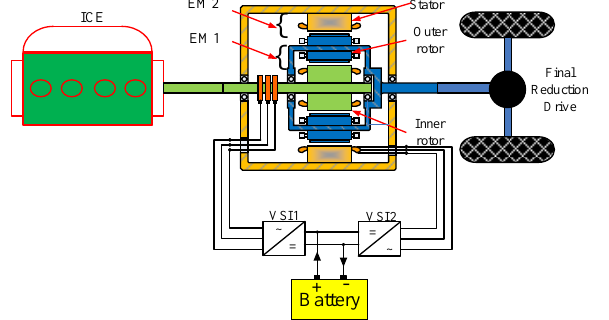
Figure 1. Power transmission topology of hybrid electric vehicle based on a composite structure motor (CSM-HEV).